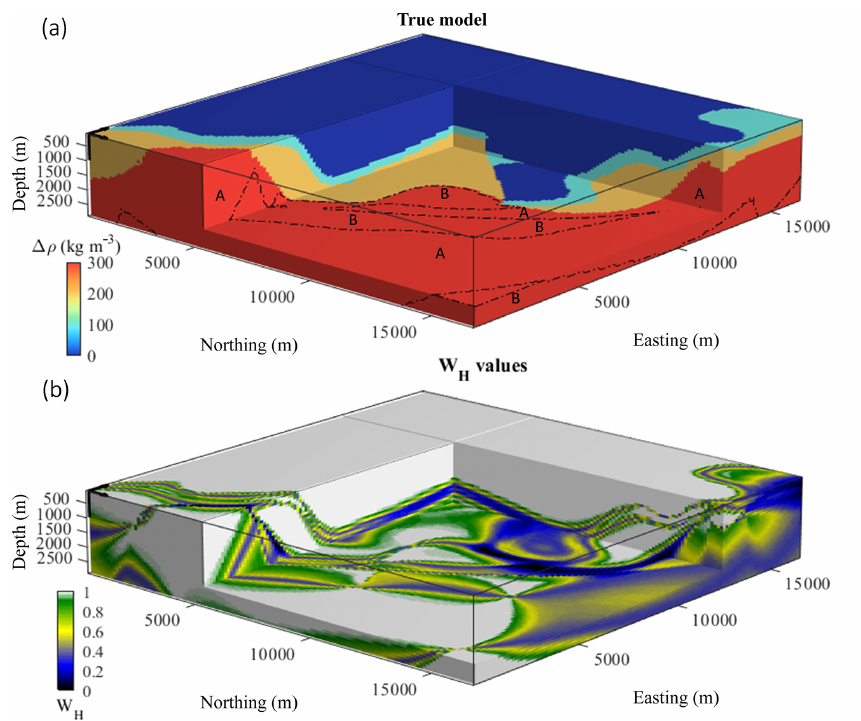
Figure 3. (a) True density contrast model with outline of the “ghost” unit B (black dashed line), embedded in ultramafic unit A, and (b) local weights calculated from the PGM calculated using MCUE for model (a)